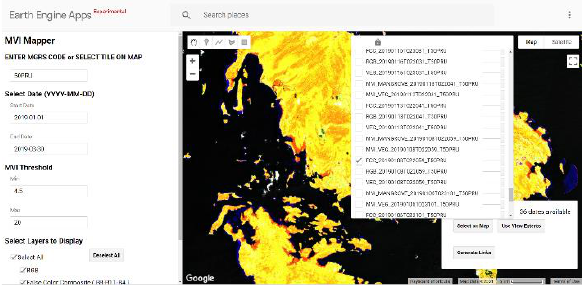
Figure 2. Google Earth Engine-based MVI Mapper interface.